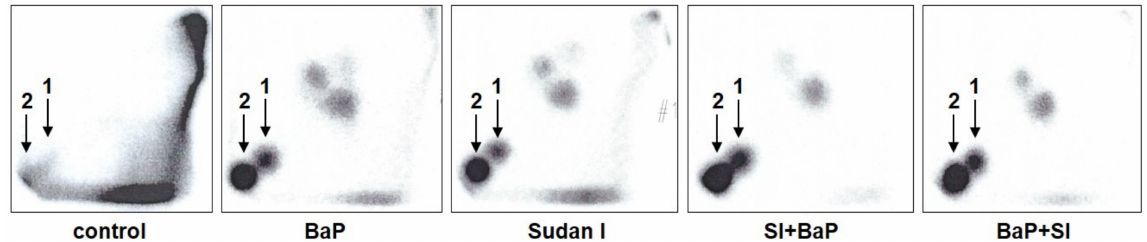
Figure 3. Autoradiographic profiles of DNA adducts formed in incubations of calf thymus DNA with BaP, NADPH (cofactor) and hepatic microsomes isolated from livers of control (untreated) rats and rats exposed to BaP alone, Sudan I alone, Sudan I before BaP treatment (SI + BaP) or Sudan I after BaP treatment (BaP + SI). Adduct 1—dG- N 2 -BPDE; adduct 2—hydroxy-BaP-4,5-epoxide-derived guanine adduct. The origin on the TLC plate, at the bottom left-hand corners, was cut off before